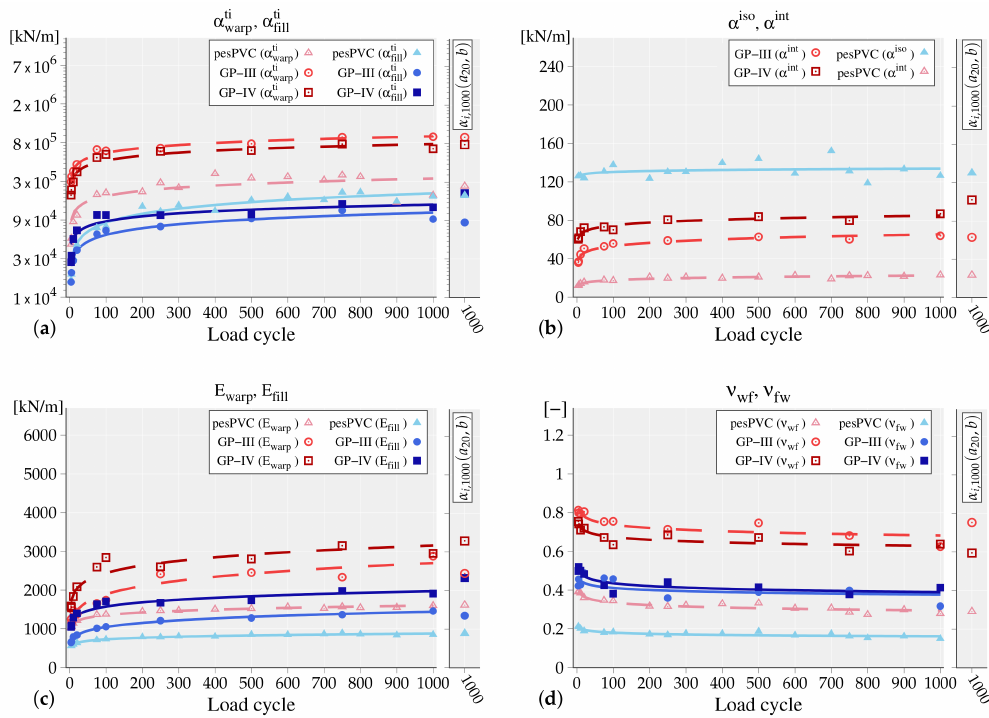
Figure 6. The material parameters (shown as dot) and the estimation function results (shown as dashed and solid lines) are illustrated. ( a , b ) The nonlinear material model parameters. ( c , d ) The linear elastic parameters. Next to each graph, the estimated parameters from the LC 20 data α i ,1000 ( a 20 , b ) are additionally marked at LC